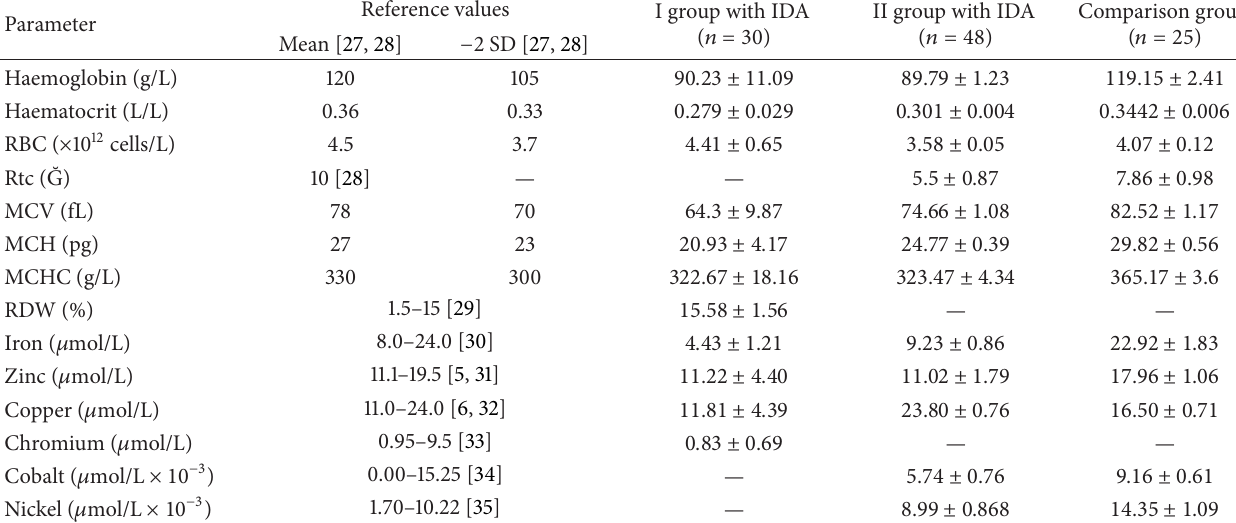
Table 1: Haematological parameters and content of trace elements in blood serum of children with